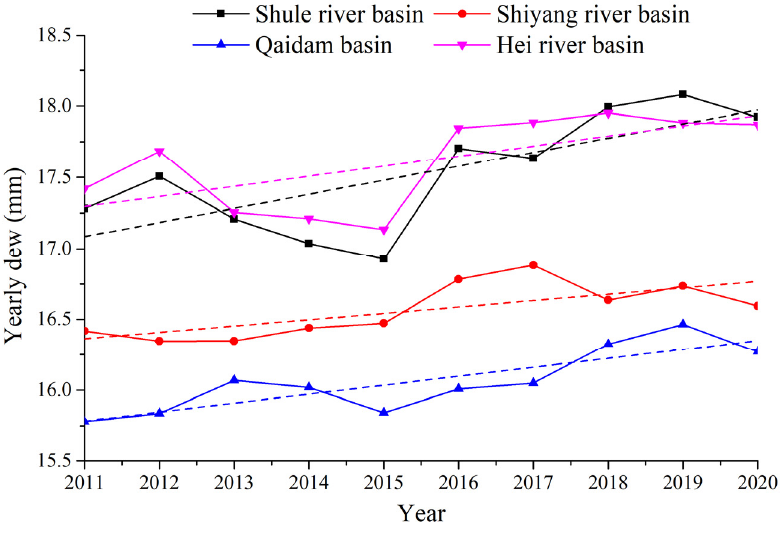
Figure 13. Annual dew variation in four typical basins in Northwest China (2011–2020), with the dashed line as the fitted line ( p < 0.05).